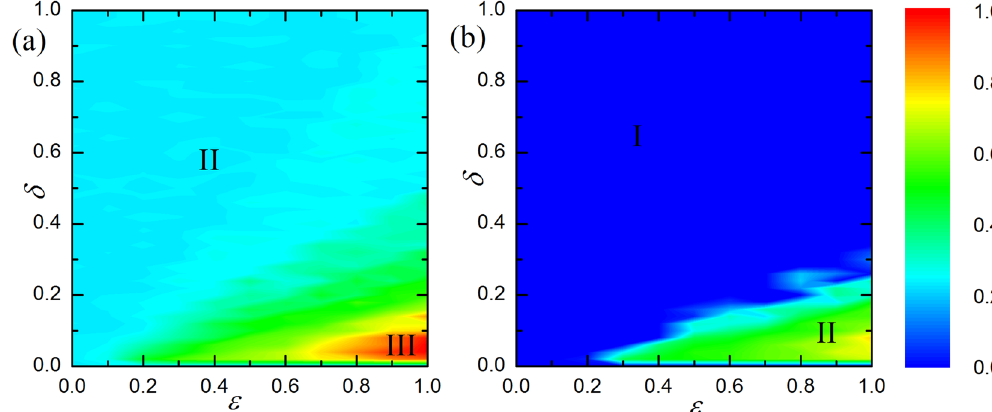
Figure 2. Color-code (see bar on the right) fraction of cooperation on the δ ε − parameter plane for b = 1.03 (Fig. 2(a)) and b = 1.06 (Fig. 2(b)). Both panels show that the optimal value, where cooperation is best promoted, is about 0.05 irrespective of which temptation to defect b applies.